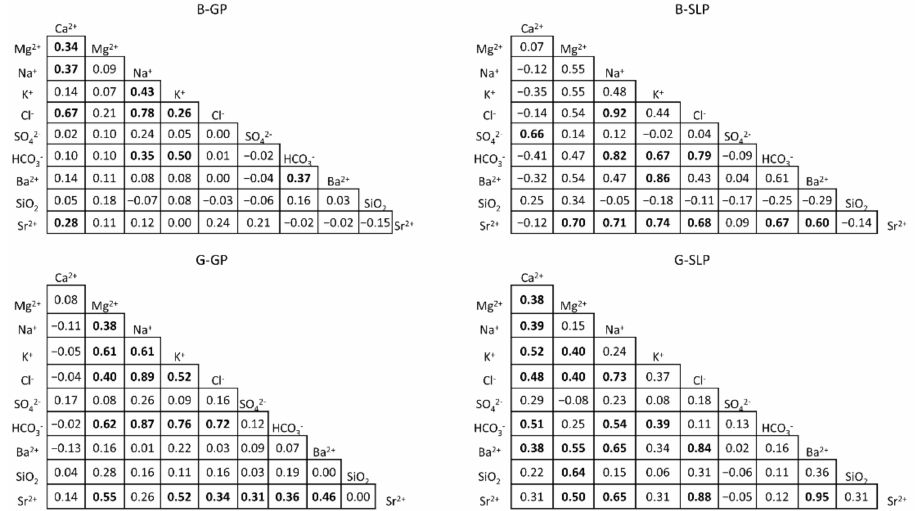
Figure 3. Correlation matrix of elements for the four data sets. Coefficient correlations in bold characters are considered as significant correlations according to Equation